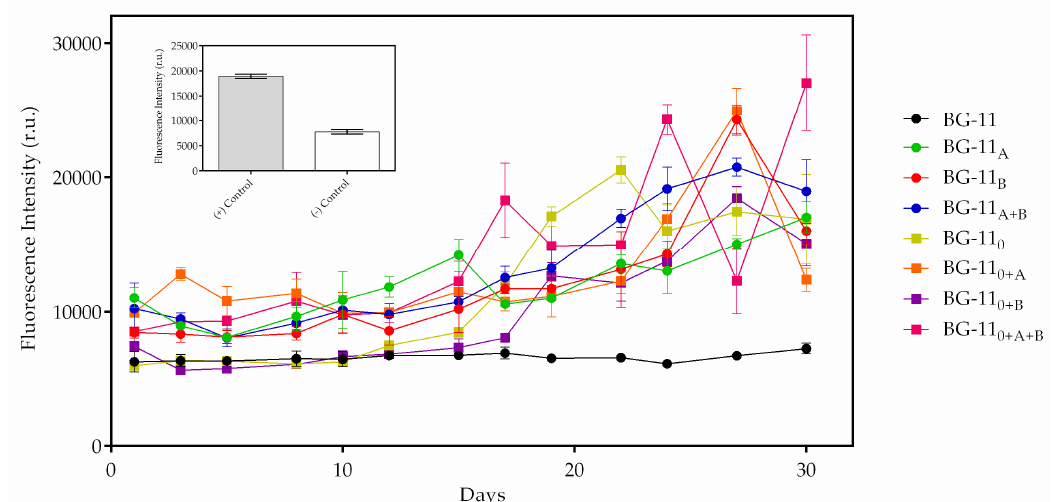
Figure 5. Quantitative fluorescence intensity of Stigeoclonium sp. B23 in eight modified growth conditions. Data are the mean ± SD of three replicates. (+) Control: crotonic acid, distilled water, and Nile Red, (-) Control: distilled water and Nile Red.